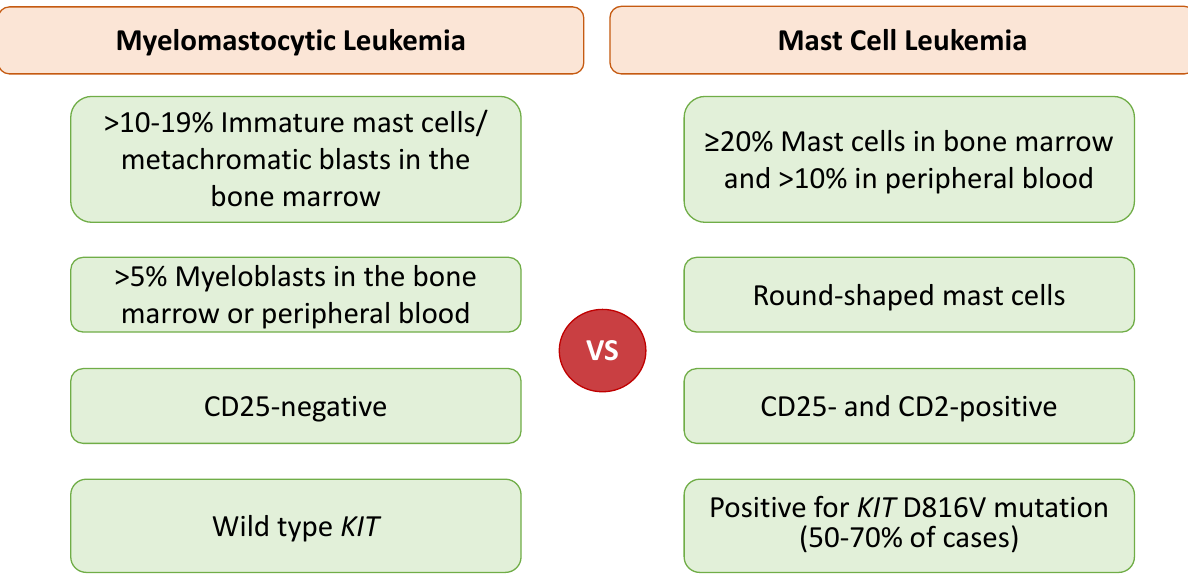
Figure 2. Comparison of diagnostic criteria in myelomastocytic leukemia versus mast cell